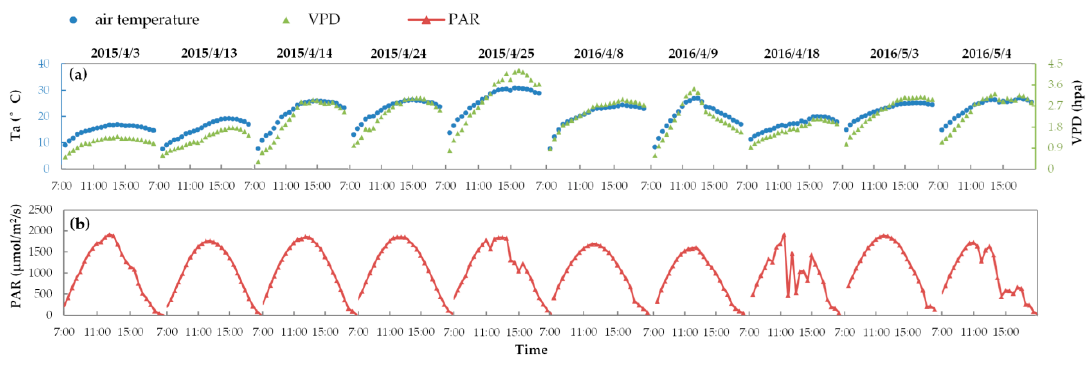
Figure 1. Diurnal observations of meteorological parameters between 7:00 to 19:00 made during ten experiments in 2015 and 2016: ( a ) half-hour air temperature and VPD observations and ( b ) half-hour PAR observations.